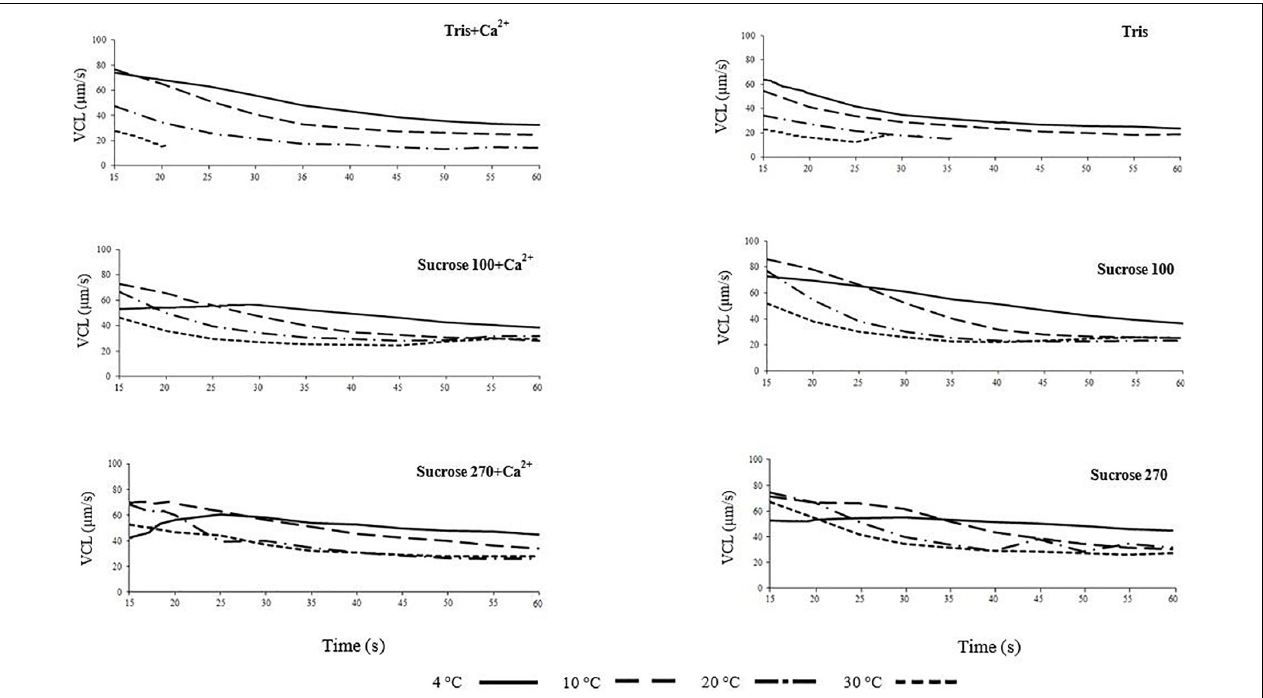
FIGURE 1 | Curvilinear velocity (VCL) of Lota lota spermatozoa in relation to time post-activation (up to 60 s) at 4, 10, 20, and 30 ◦ C in Tris, Tris + Ca 2 + , Suc100, Suc100 + Ca 2 + , Suc270, and Suc270 + Ca 2 +